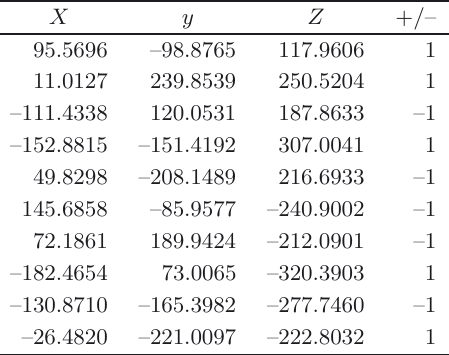
Table 1. Ten points that lie exactly on an elliptic hyperboloid that can be used to define a vertex solution for the ChODR